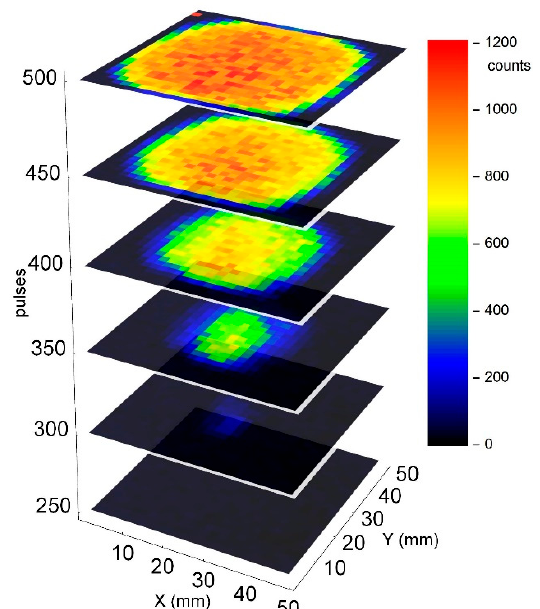
Figure 7. Mapped line intensity as a function of depth for a galvanized sample with 10 µm coating thickness in the centre.